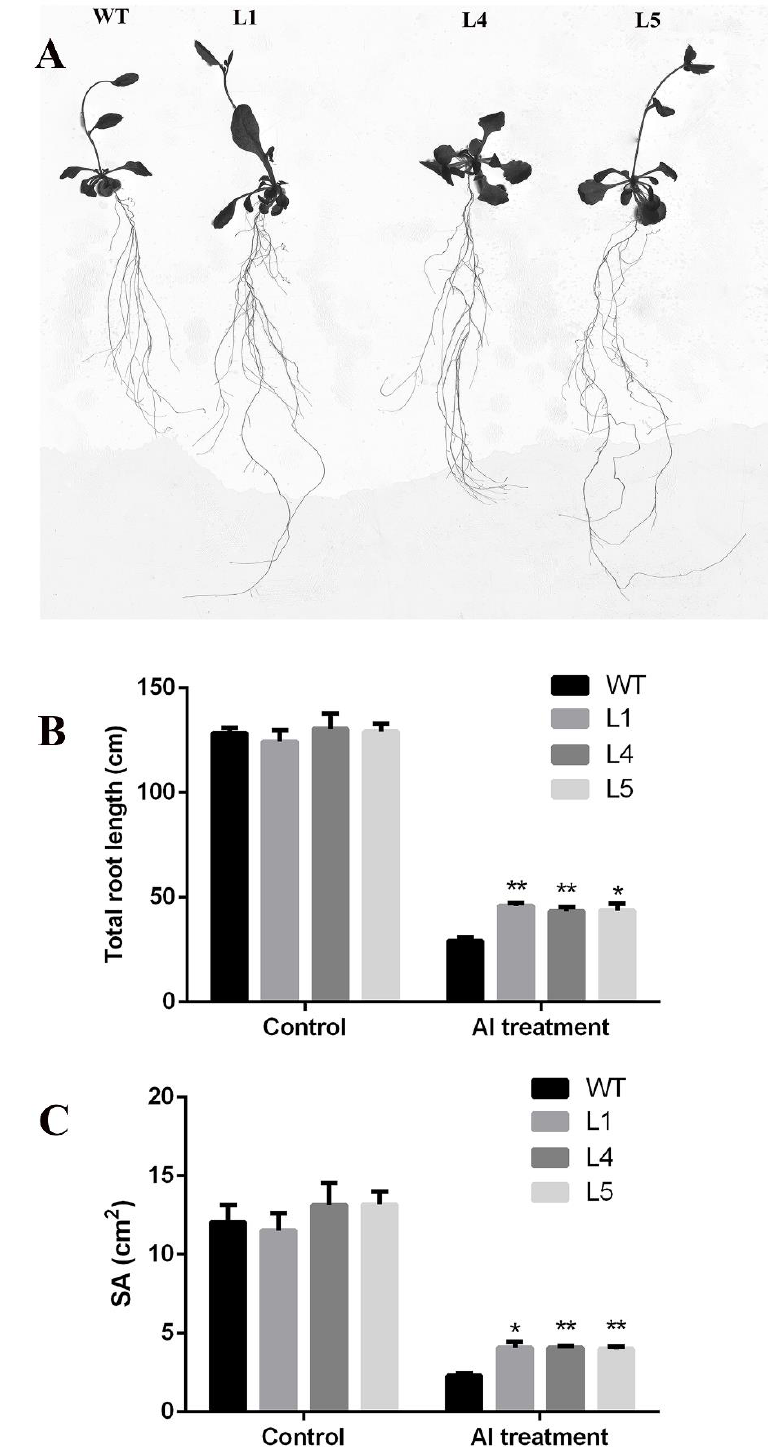
Figure 5. Phenotype observation and indexes determination. ( A ) The phenotype of transgenic lines and control in 1 / 30 Hoagland nutrient solution with 2 µ M AlCl 3 . ( B ) The total root length. ( C ) The total root surface area. Asterisks indicate significant di ff erences between WT and GsGIS3 transgenic lines (* P < 0.05; ** P < 0.01). WT, wild-type of Arabidopsis (Col-0); L1, L4 and L5 GsGIS3 Arabidopsis transgenic lines of T 3 generations; SA, the total root surface area. Three independent biological experiments were carried out to investigate the status of seedlings and measure the root indexes.